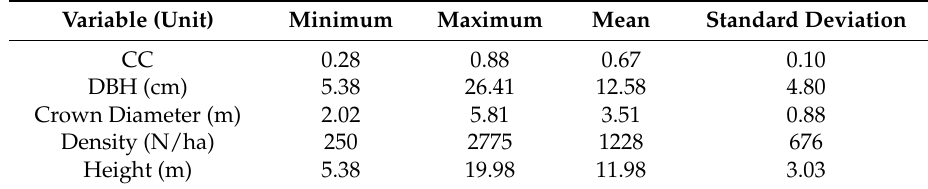
Table 1. Summary of the characteristics of the forest field